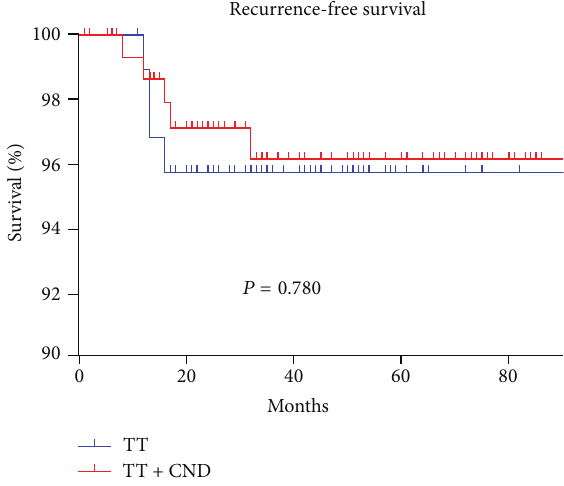
Figure 1: Recurrence rate according to the operation